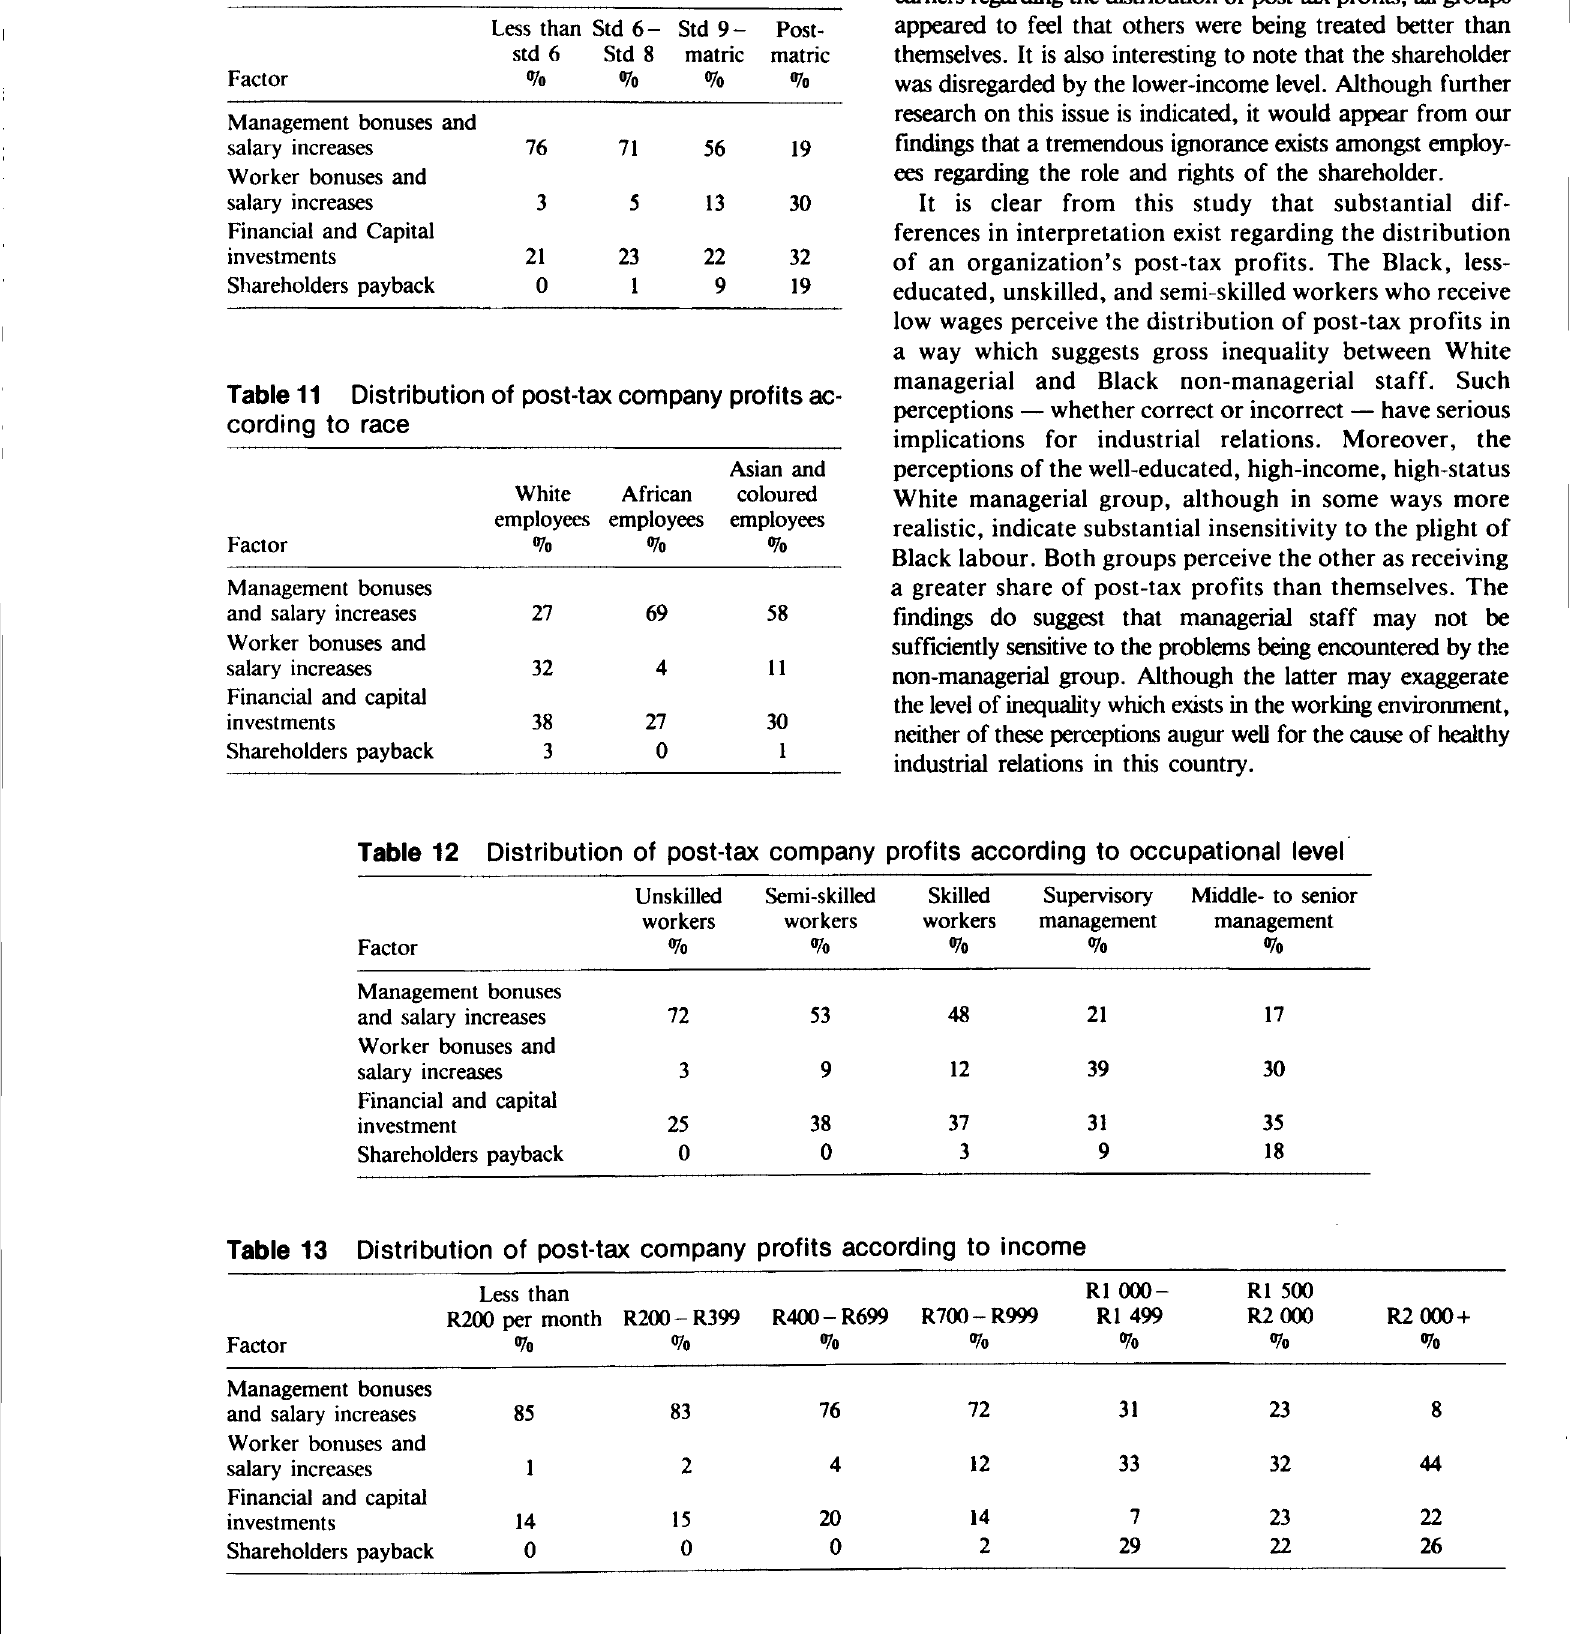
Distribution of post-tax company profits ac-